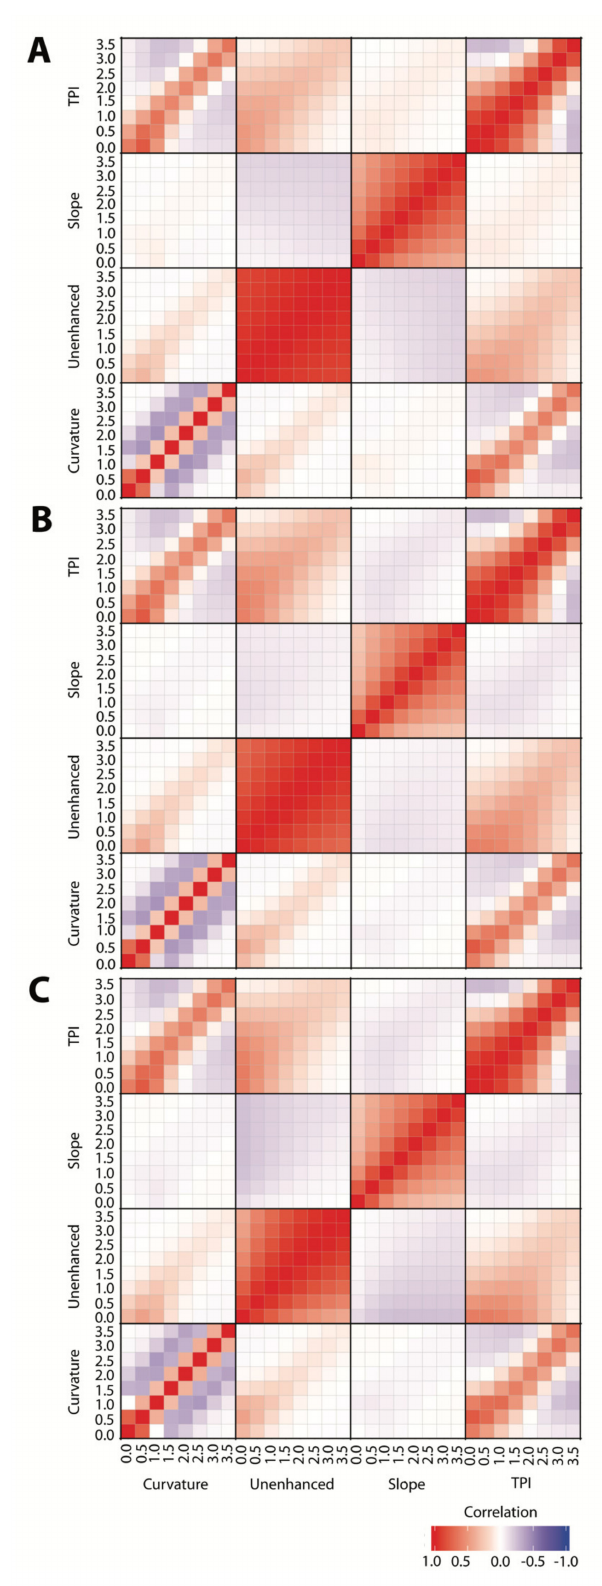
Figure 5. Pearson’s Correlation coefficients ( ρ ) for all combinations of distances of 0 to 3.5 m from cave entrances for curvature, slope, TPI (topographic position index), and unenhanced thermal for ( A ) predawn, ( B ) midday, and ( C ) difference imagery. Paired comparisons were perfectly positively ( ρ = 1.0) and perfect negatively ( ρ = − 1.0) correlated is 1.0; no correlation is ρ =